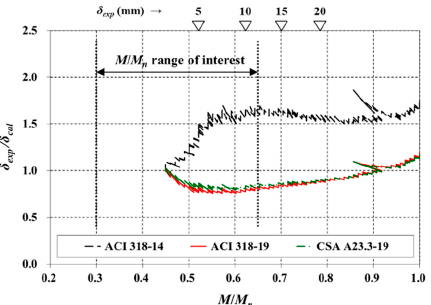
Figure 6. Comparison of immediate deflection (S slab). The bottom reinforcement of S250P was 6-D13, and the ρ was relatively small with a value of 0.283%. The ACI 318-14 code, which uses Equations (5) and (6) in predicting the δ cal , significantly underestimates deflection, similarly to previous studies [16–20]. Conversely, the deflection calculated using the ACI 318-19 code yielded improved results. The CSA A23.3-19 standard, which is based on 0.5 f r (i.e., 0.5 M cr ) and Equation (5), also predicted